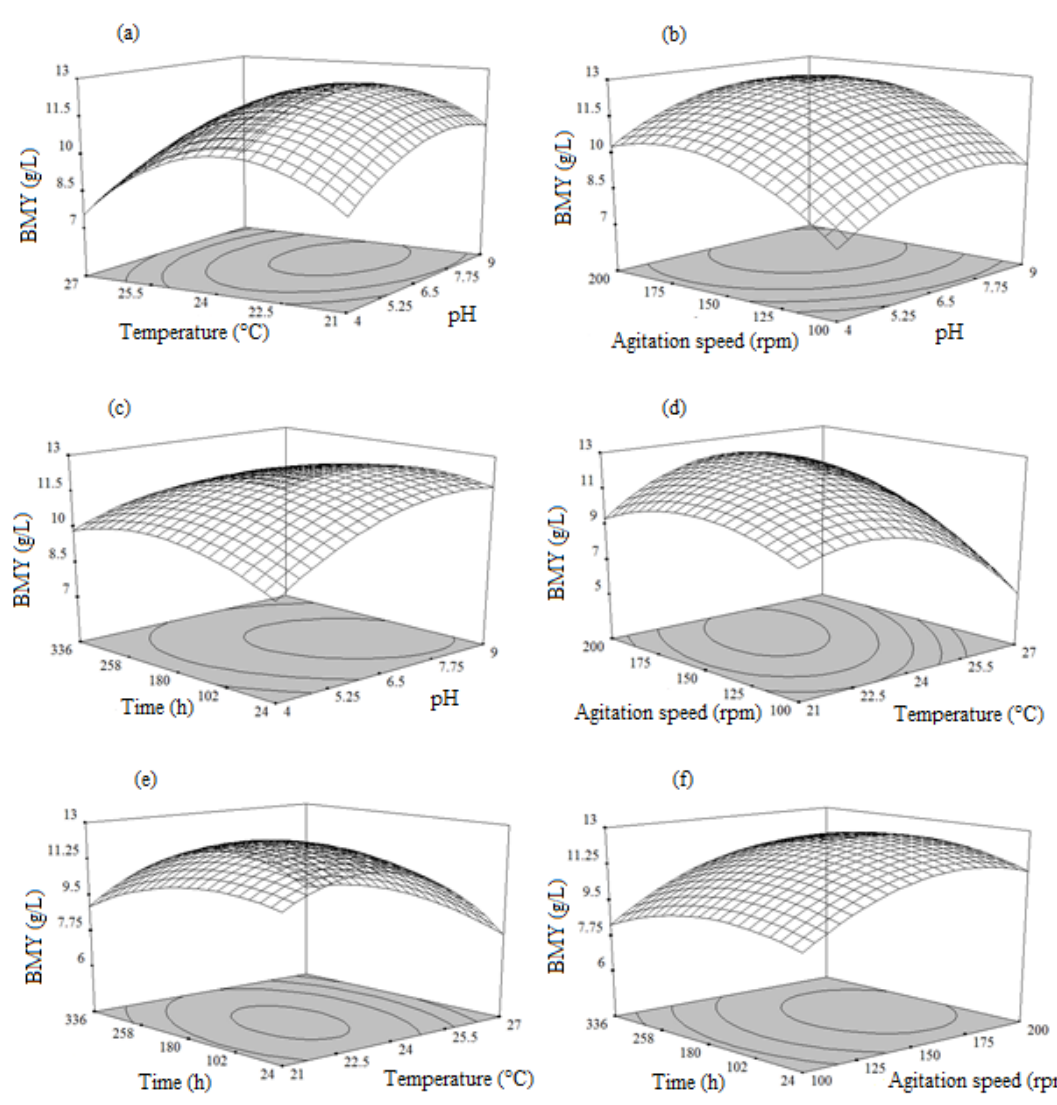
Figure 3. Response surface plots showing the influence of the process variables on dry biomass yield: ( a ) Interaction between temperature and pH; ( b ) Interaction between agitation speed and pH; ( c ) Interaction between time and pH; ( d ) Interaction between agitation speed and temperature; ( e ) Interaction between time and temperature; ( f ) Interaction between time and agitation speed.